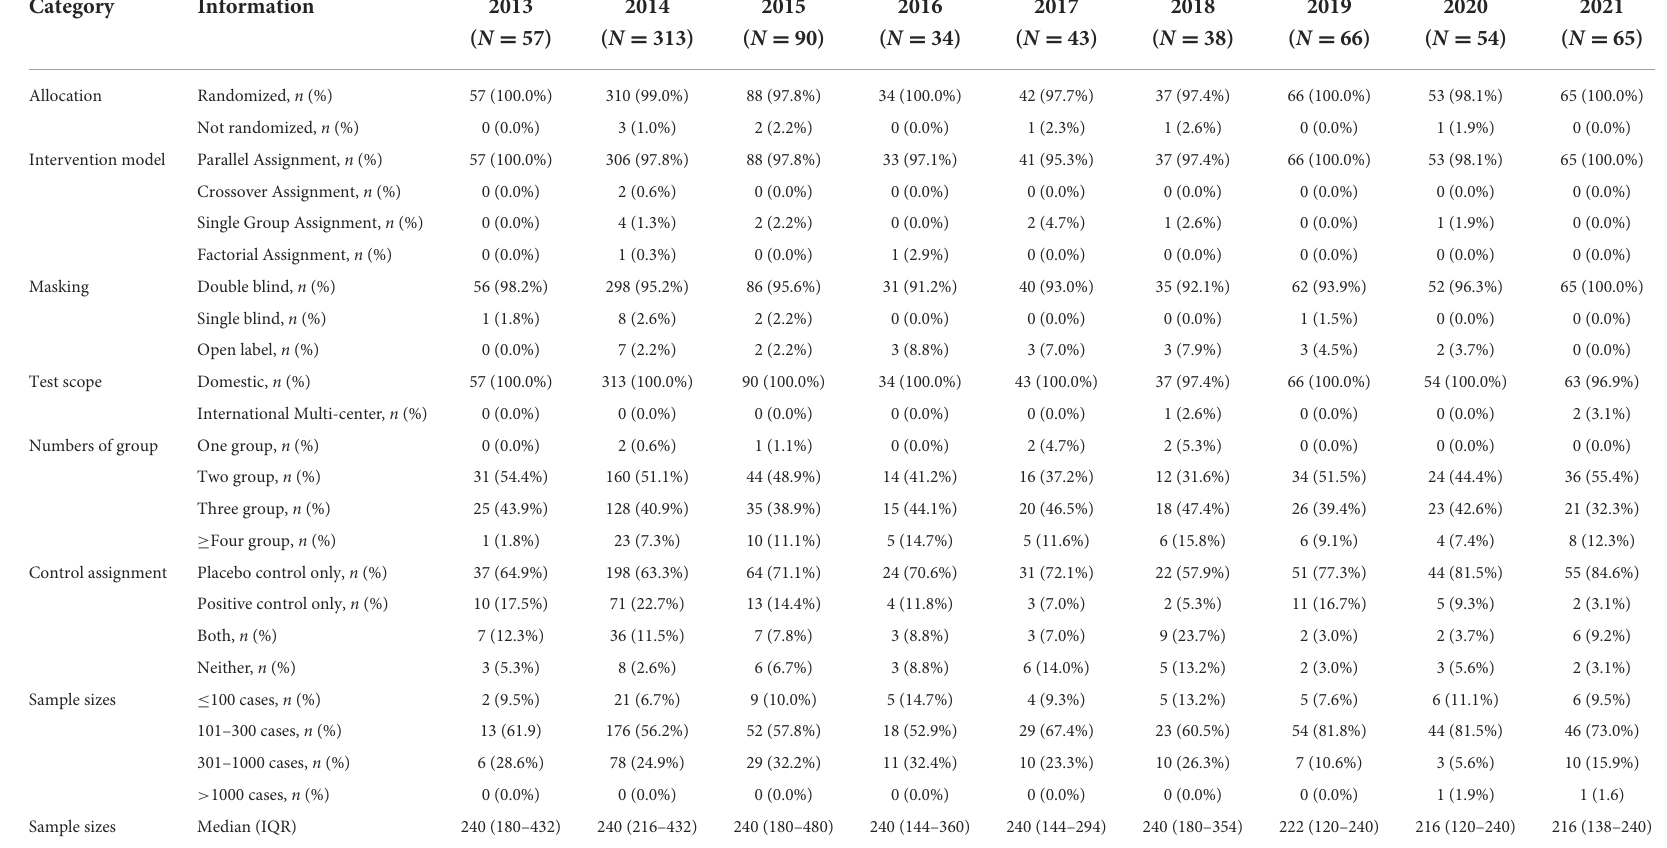
TABLE 2 Trial characteristics and designs for phase II–phase III trials in different